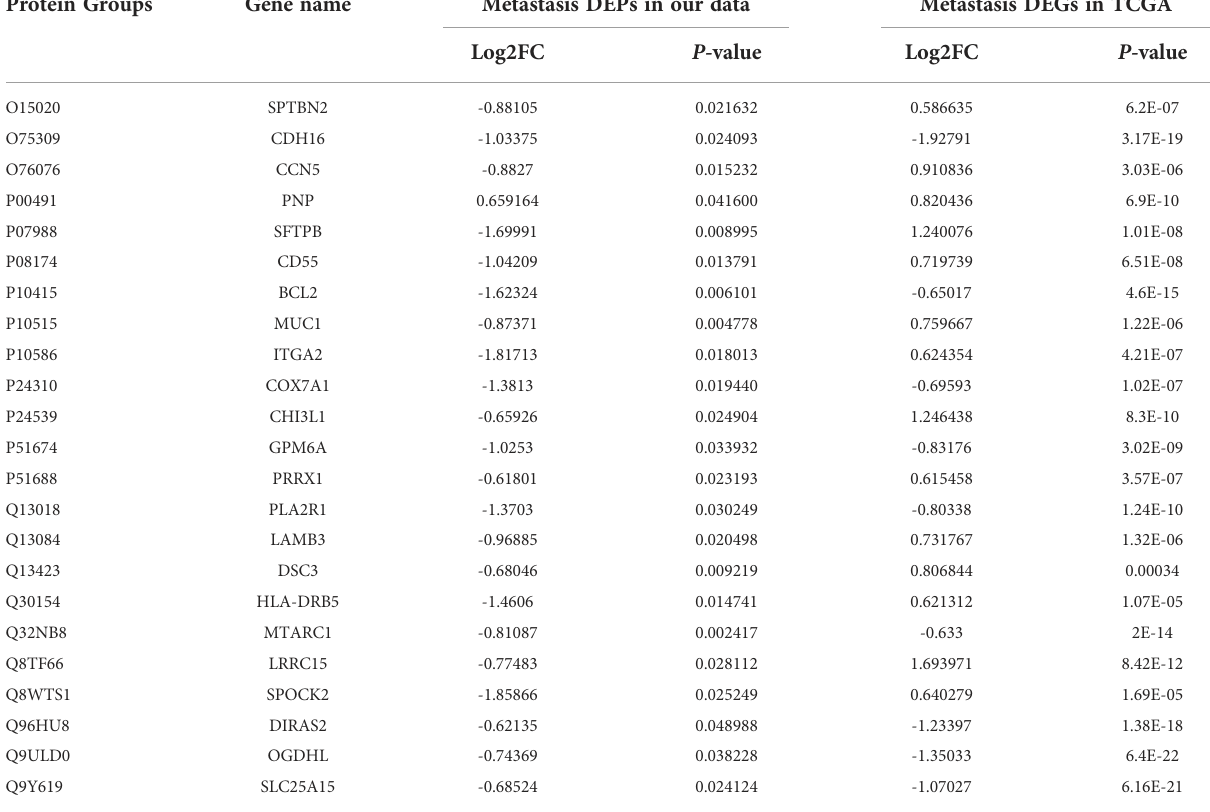
TABLE 2 Intersection containing 23 DEGs associated with